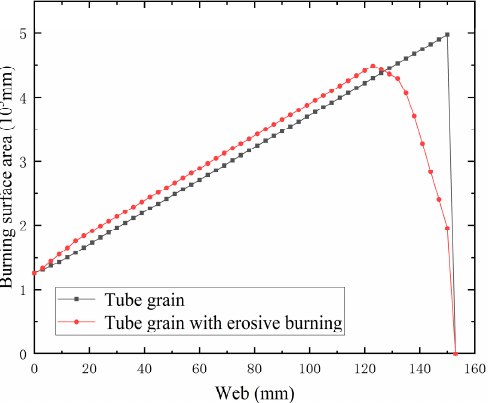
Figure 10. Burning process of tube grain under erosive burning.